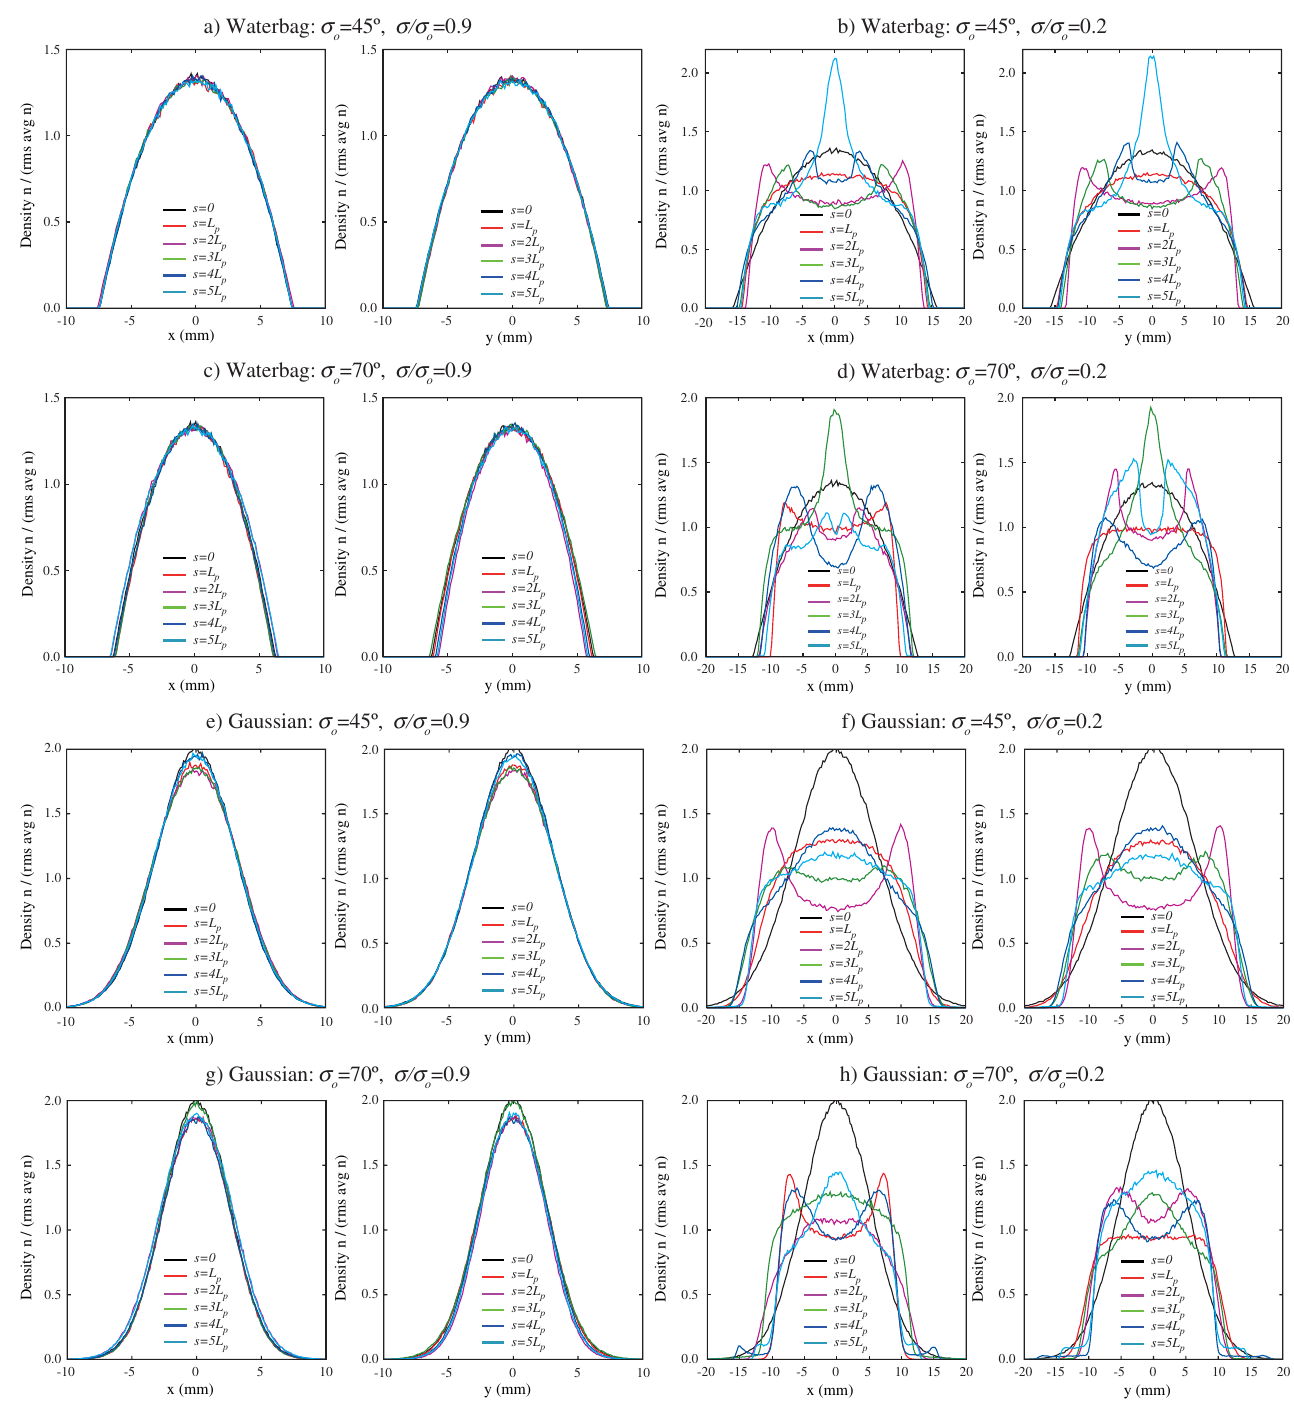
¼ 45 (cid:5) , (cid:3)=(cid:3) ¼ 0 : 9 ; 0 0 ¼ 70 (cid:5) , (cid:3)=(cid:3) ¼ 0 : 2 ; (e) Gaussian 0 0 ¼ 70 (cid:5) , (cid:3)=(cid:3) ¼ 0 : 9 ; and (h) Gaussian f , 0 0 ¼ 50 , r